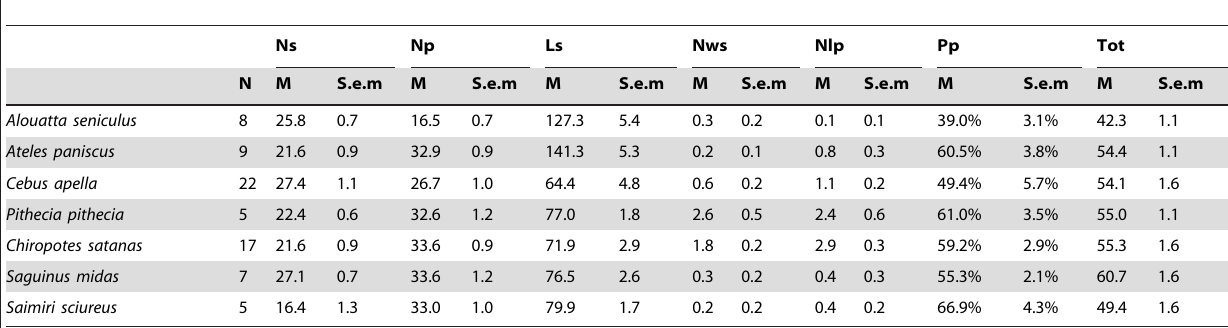
Table 1. Mean and standard deviation for each microwear variable and for each taxon of the Cachoeira primate community.